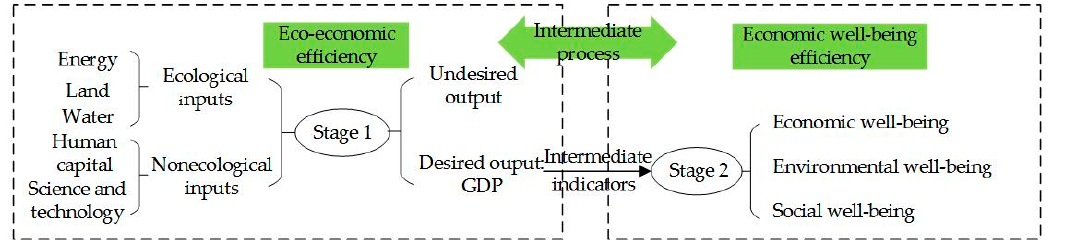
Figure 2. Eco-economic efficiency and economic well-being efficiency transformation system of EWP in China.